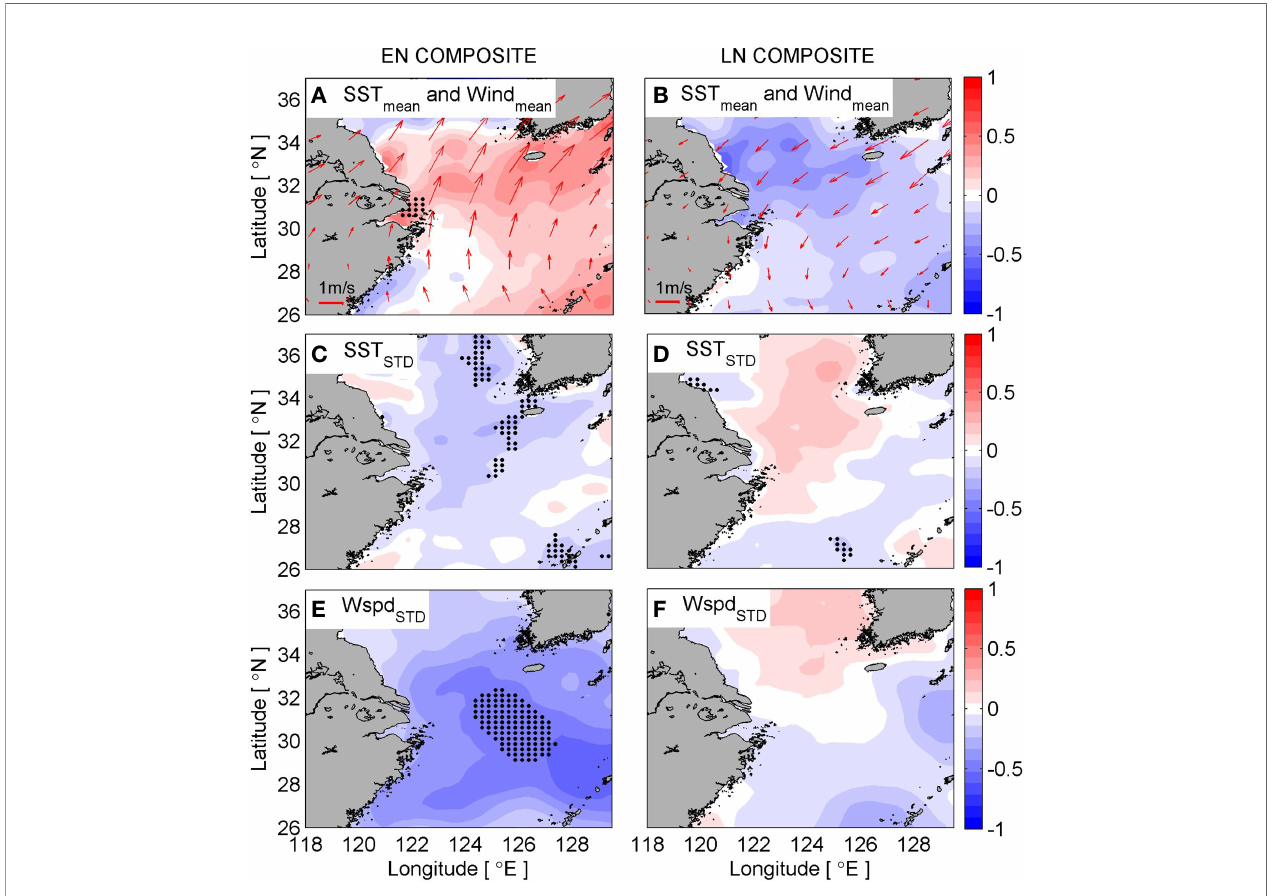
FIGURE 8 | Composite differences of (A) SST (color) and surface wind (vector), (C) SST standard deviation, and (E) wind speed (Wspd) standard deviation in August for fi ve El Niño years (1998, 2003, 2005, 2007, and 2010) and climatology mean. Stippling indicates that the differences are statistically signi fi cant at the 95% level. (B , D , F) are the same as (A , C , E) , but for eight La Niña years (1999, 2000, 2001, 2006, 2008, 2009, 2011, and 2012).